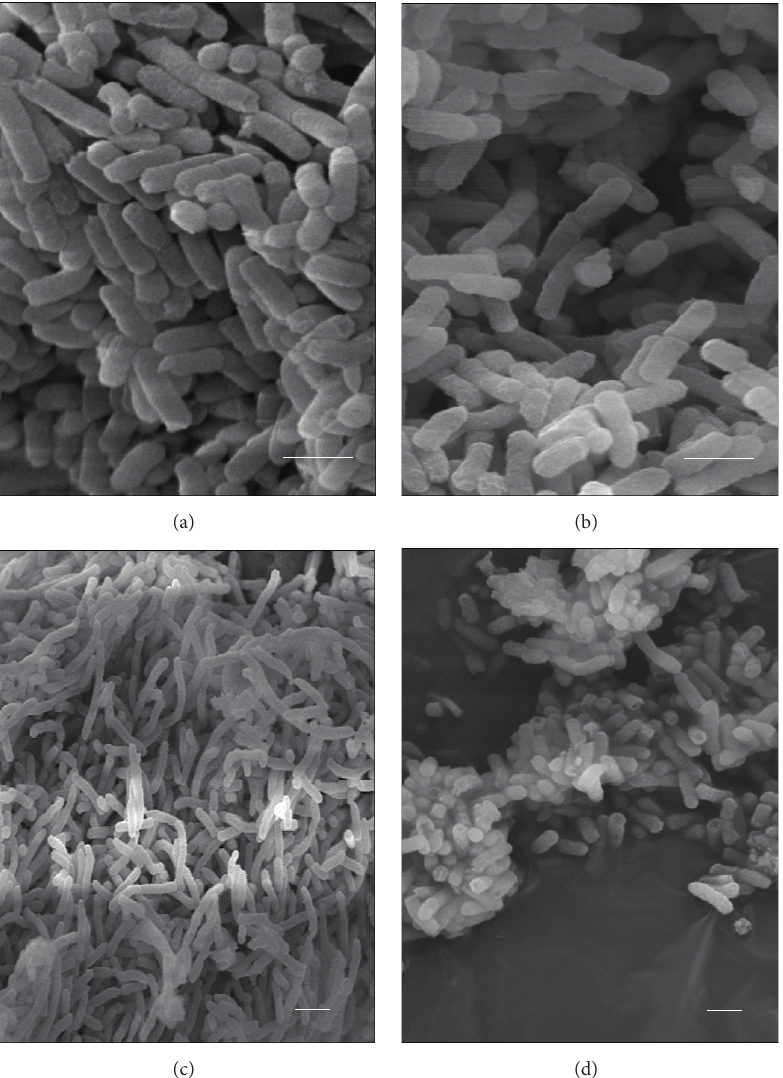
Figure 5: (a–d) Scanning electron micrographs of isolate K16R. (a) Control cells with preserved morphology. (b) Cells subjected to CTX (32 𝜇 gmL −1 ). (c) Cells subjected to CAZ (16 𝜇 gmL −1 ). (d) Cells subjected to ATM (4 𝜇 g mL −1 ). Bars = 2 𝜇 m. CAZ: ceftazidime; CTX: cefotaxime; and ATM: